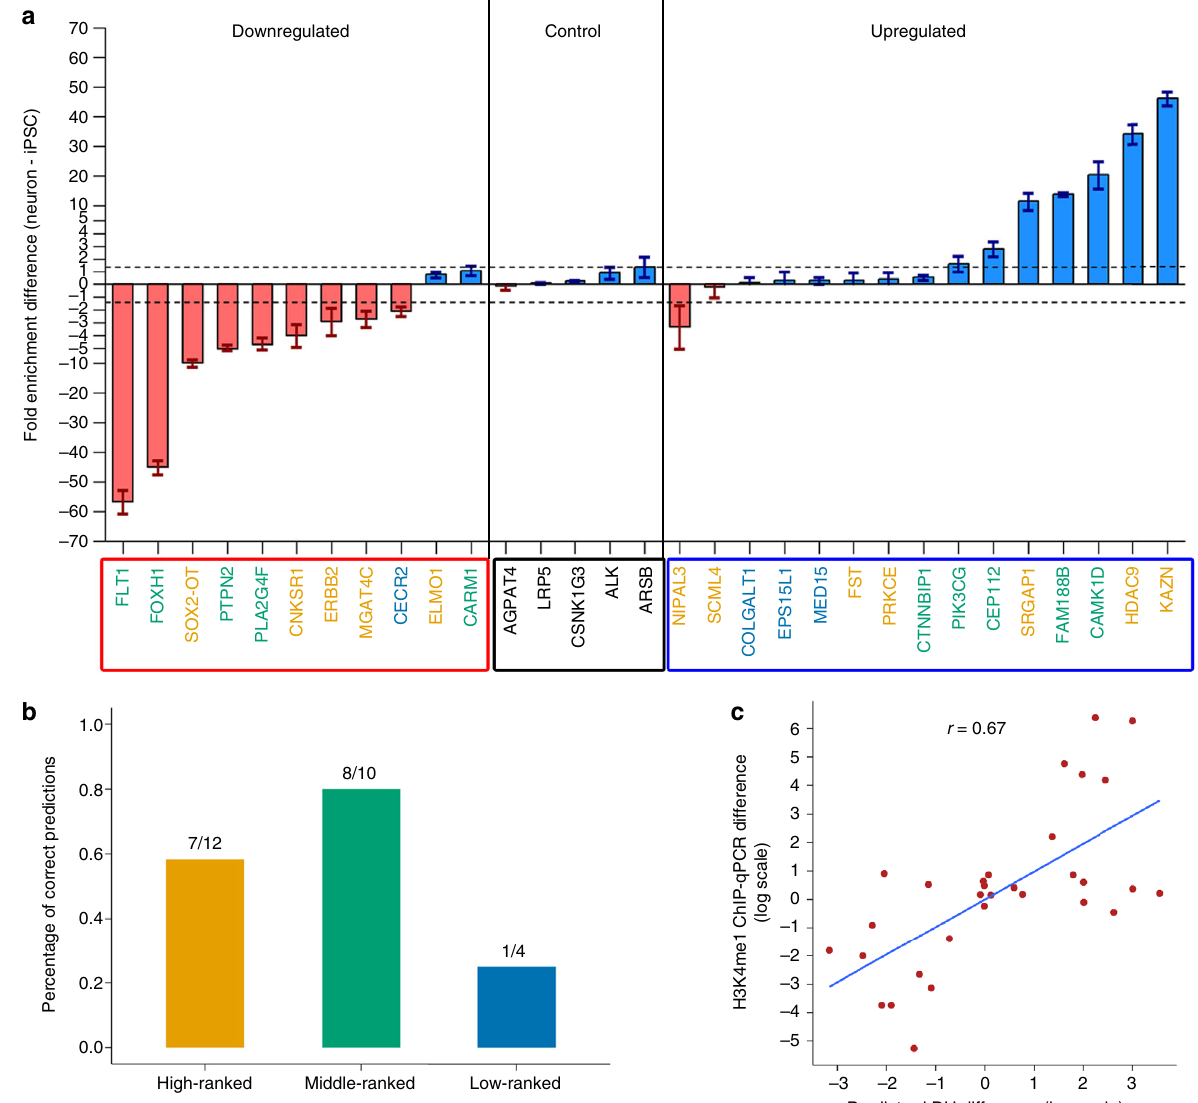
Fig. 7 Predicting differential activities of regulatory elements during neuronal differentiation. a Difference in H3K4me1 measured by ChIP-qPCR between iPSCs and iPSC-derived neurons for 26 DHSs at different predicted fold change levels (i.e., absolute value of log2 fold change δ j j > 2, 1 < δ j j ≤ 2, and 0.1 < δ j j ≤ 1, indicated by yellow, green, and blue, respectively, in the gene labels) and fi ve non-differential DHSs ( “ control ” ) predicted by BIRD. The 26 DHSs were further divided into up regulated and downregulated DHSs after differentiation based on the predicted DH. Dashed lines represent ± maximum | ChIP- qPCR measured H3K4me1 difference in fi ve control DHSs | . Data are presented as mean ± s.e.m. (iPSCs and iPSC-derived neurons each had n = 3 technical replicates). b Validation rate of differential DHSs: 7/12 high-ranked ( δ j j > 2) DHSs, 8/10 middle-ranked (1 < δ j j ≤ 2) DHSs, and 1/4 low-ranked (0.1 < δ j j ≤ 1) DHSs were validated by ChIP-qPCR. c Correlation between the predicted differential DH (i.e., difference in the predicted DH signals (at log2 scale) between iPSCs and iPSC-derived neurons) and the ChIP-qPCR measured H3K4me1 difference (log2 fold change) across the 31 DHSs tested by ChIP-qPCR. Each dot is a DHS. The Pearson ’ s correlation coef fi cient is shown on the top